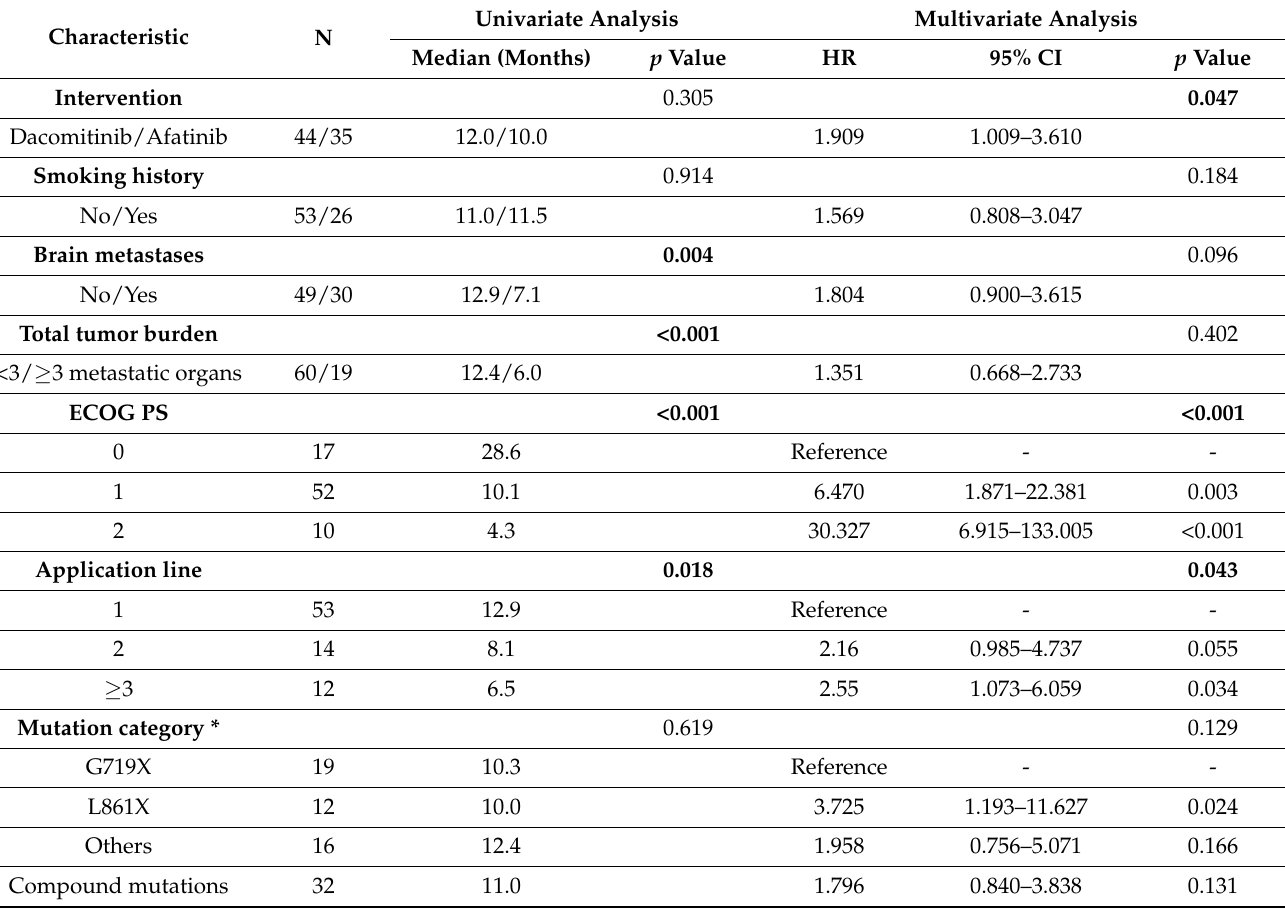
Table 2. Univariate and multivariate analyses of PFS in the pooled cohort of the DC and the AC (N = 79). Univariate Analysis Multivariate